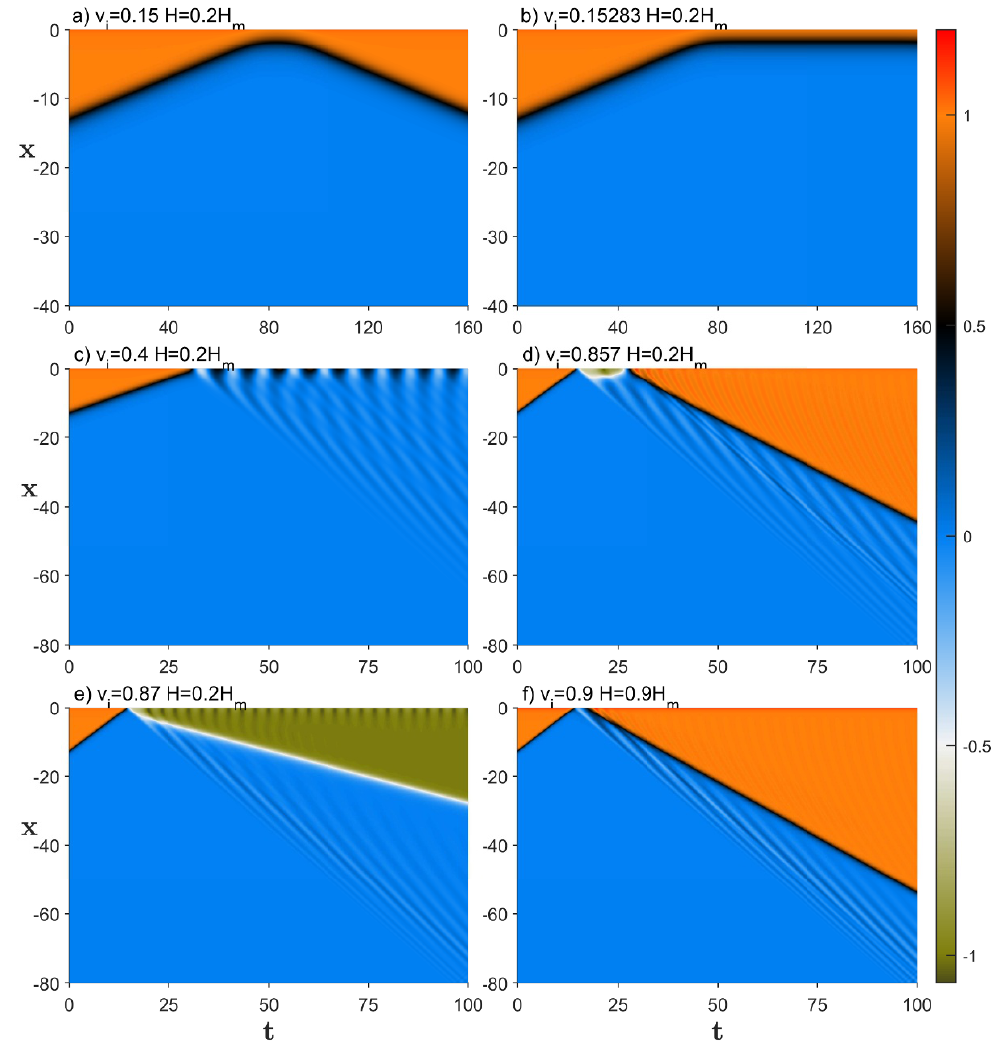
Figure 20 . Φ 1+ kink scattering with ˜ φ 3 boundary, showing a) quasi-elastic return b) kink with energy to reach the energy equilibrium point c) emission of radiation by the unstable φ 2 boundary d) Typical collision on top orange region of figure 21 e) Inelastic scattering f) Final state for large H